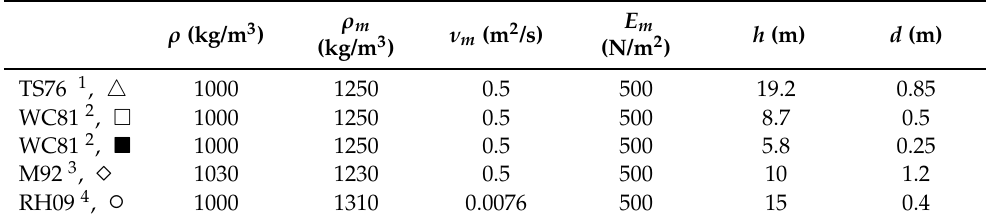
Table 1. Parameters used in the theoretical predictions of amplitude attenuation for the field examples ◦ presented in Figure 2. Symbols ( (cid:52) , (cid:3) , (cid:4) , (cid:5) , ) represent the corresponding cases shown in the figure. ρ (kg/m 3 )